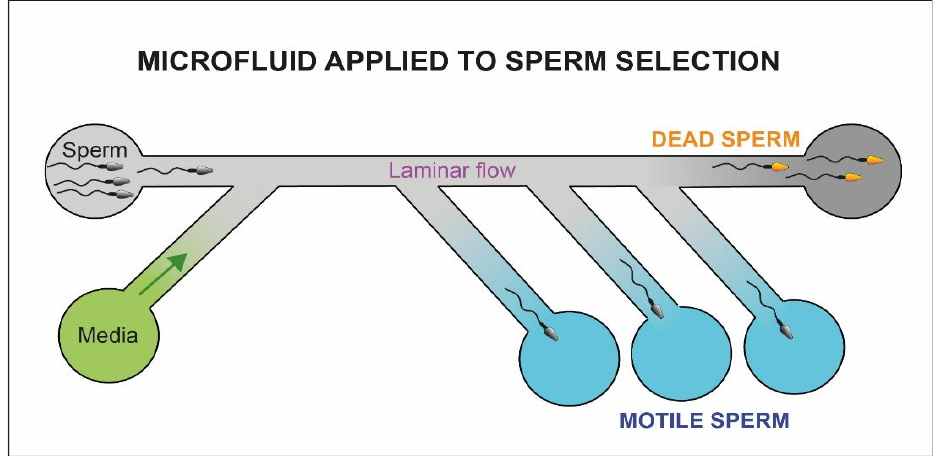
Figure 10. Schematic representation of the microfluidic system. The motile fraction of sperm cells is able to swim through the flow and be collected in separate chambers (blue chambers) while the immotile sperm cells (yellow heads) and debris reach the exit of the microfluidic system (dark